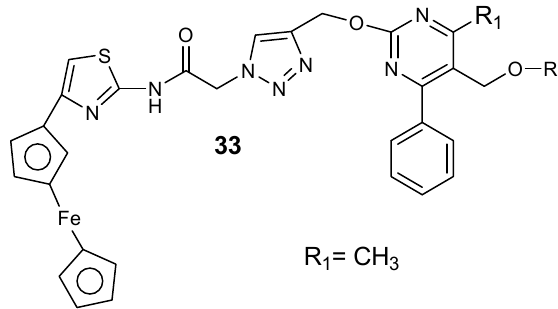
Figure 17. Structure of ferrocene–pyrimidine hybrid molecule 33 .